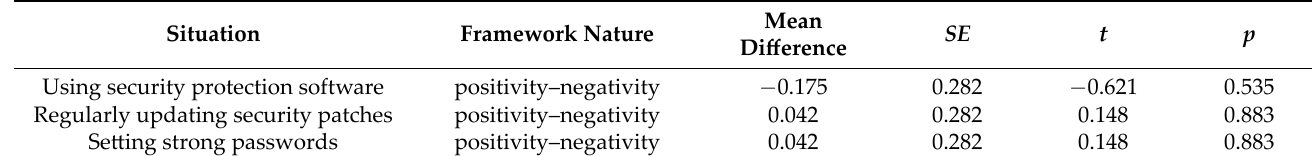
Table 12. Simple Effects (Situation and Framework Nature).